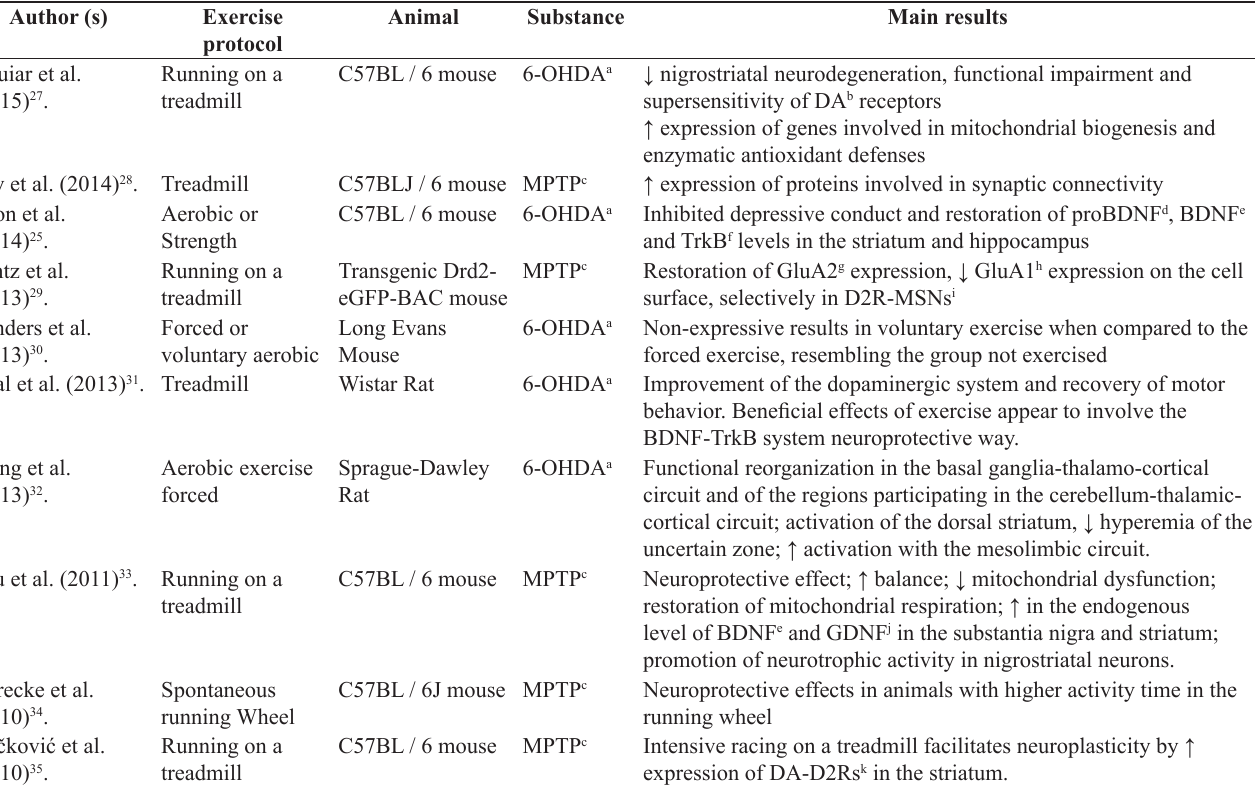
Table 1. Different types of physical exercises used and the main positive effects on Parkinson’s